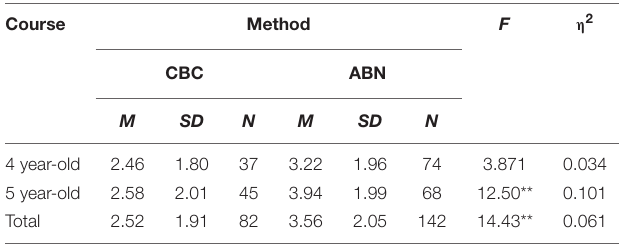
TABLE 4 | Descriptive and inferential analyses results for the numerical estimation task for CBC and ABN